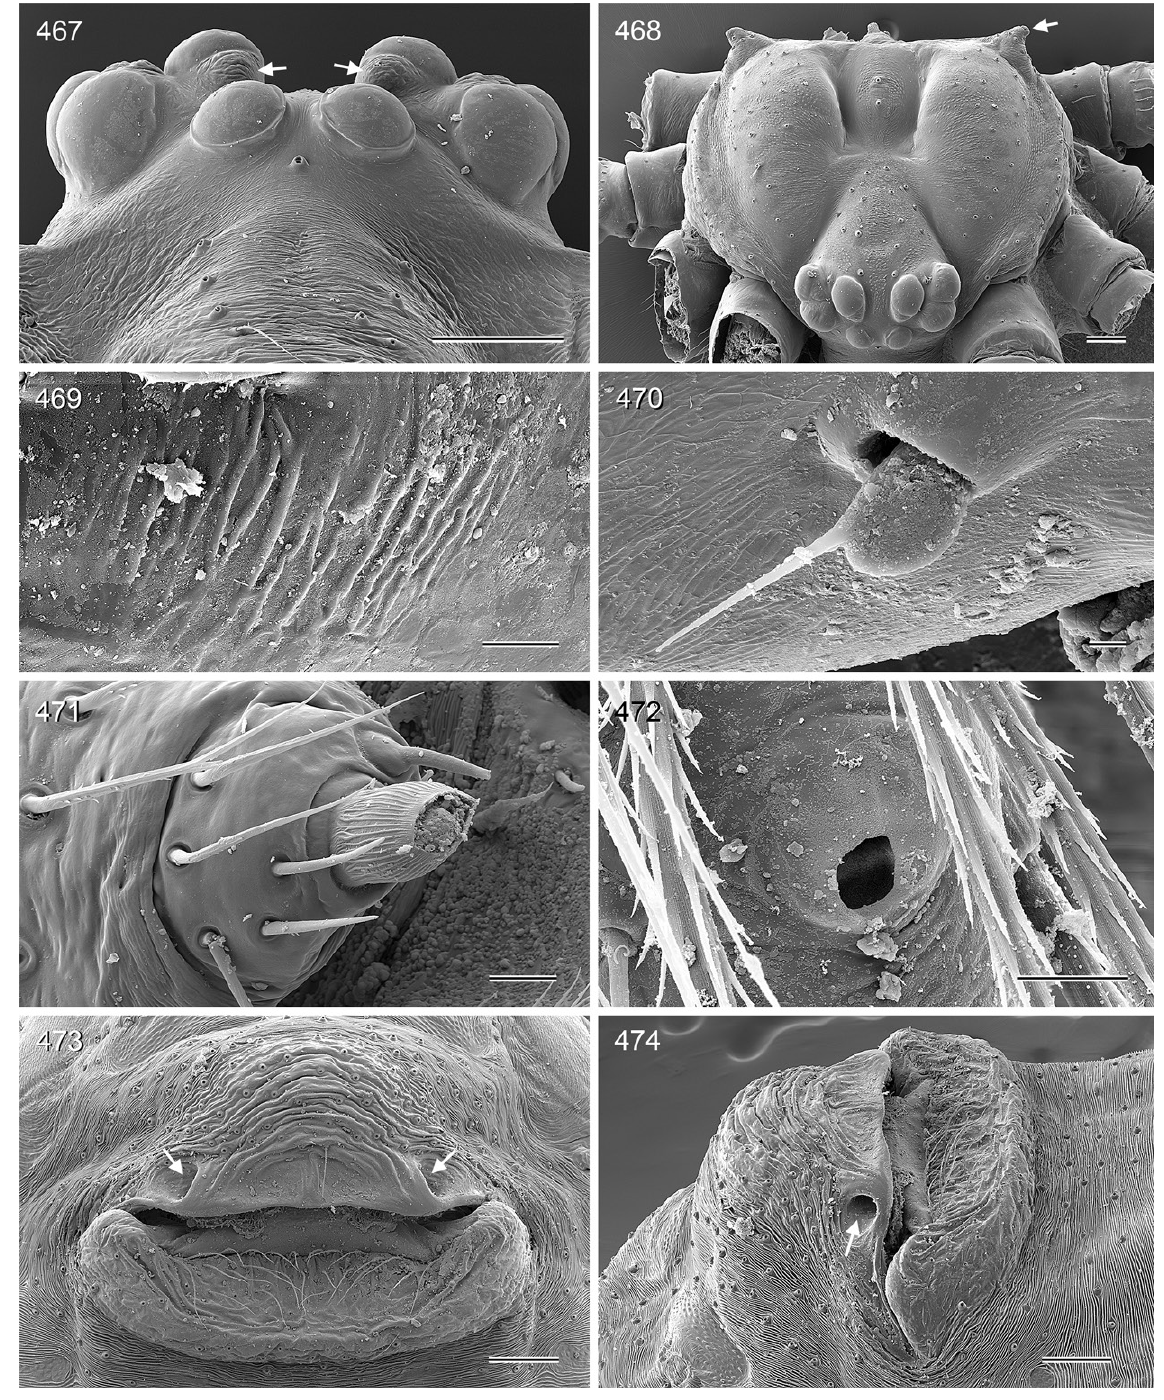
Figs 467–474. Crossopriza dhofar sp. nov.; female from Wadi Nahiz (ZFMK Ar 22413). 467 . Ocular area and clypeus; arrows: ‘pseudo lenses’. 468 . Ocular area and carapace; arrow: posterior process. 469 . Cheliceral stridulatory file. 470 . Stridulatory pick on palpal femur. 471 . ALS. 472 . Palpal tarsal organ. 473–474 . Epigynum, ventral and lateral-ventral views; arrows: pockets. Scale bars: 467–468, 473–474 = 100 µm; 469, 471–472 = 10 µm; 470 = 2